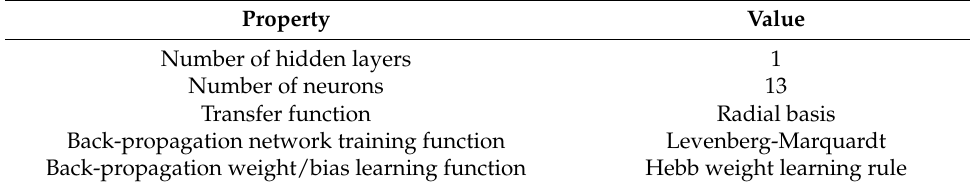
Table 1. Structure of hidden layers of the artificial neural network (ANN) used to select the key wavelengths in the artificial neural networks and the artificial bee colony algorithm (ANN-ABC) process.